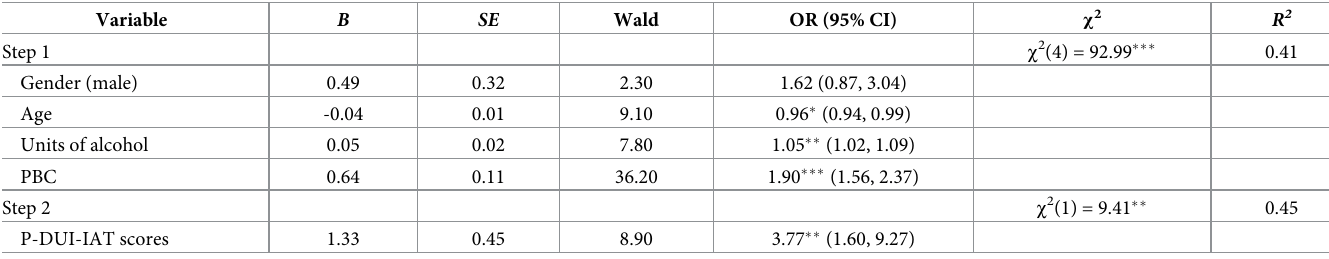
Table 6. Hierarchical logistic regression predicting past year drunk driving (Study 2).